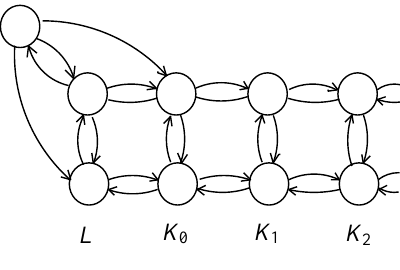
Fig. 2: Graph related to